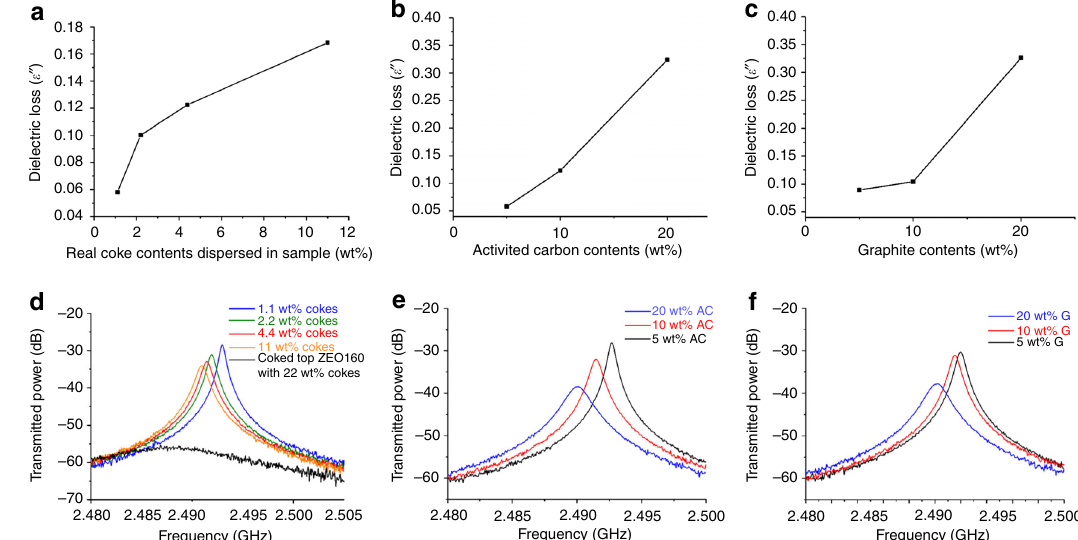
Fig. 4 Dielectric loss values of different carbon-mixed samples as a function of increasing the amount of carbons. Dielectric loss values: a Coked top ZEO 160 sample mixed with fresh pure ZEO 160. b Activated carbon mixed with fresh pure ZEO 160. c Graphite mixed with fresh pure ZEO 160. Corresponding microwave plots: d Coked top ZEO 160 sample mixed with fresh pure ZEO 160. e Activated carbon mixed with fresh pure ZEO 160. f Graphite mixed with fresh pure ZEO